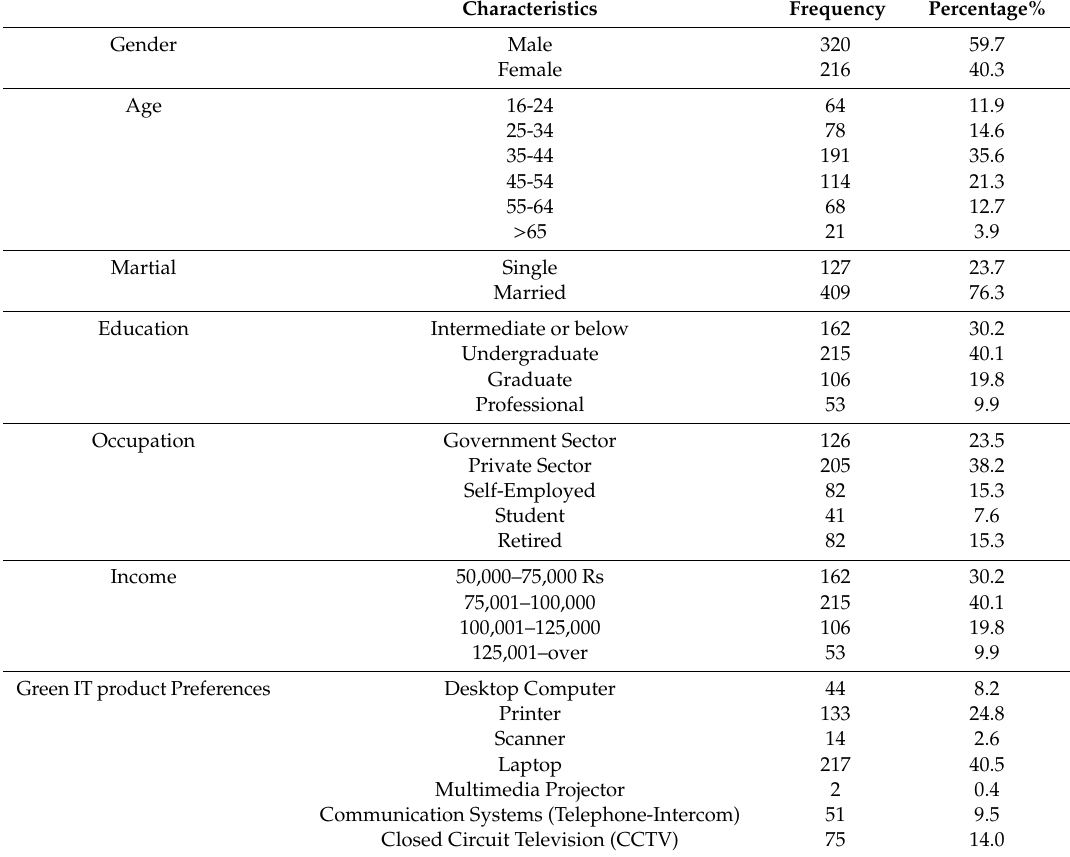
Table 2. Demographic profile of